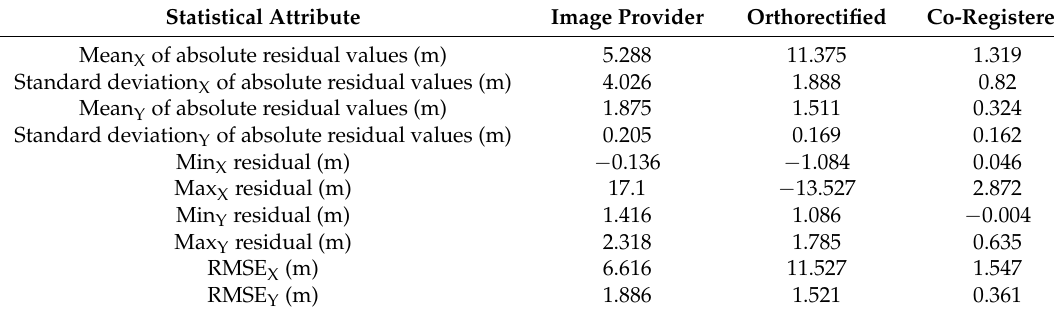
Table 3. A statistical comparison of the three image products against 41 Ground Control Points (GCPs). Statistical